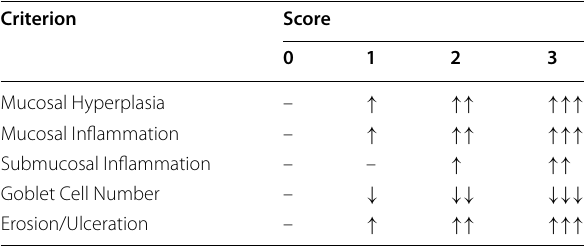
Table 1 Histopathological scoring system to quantify the degree of intestinal